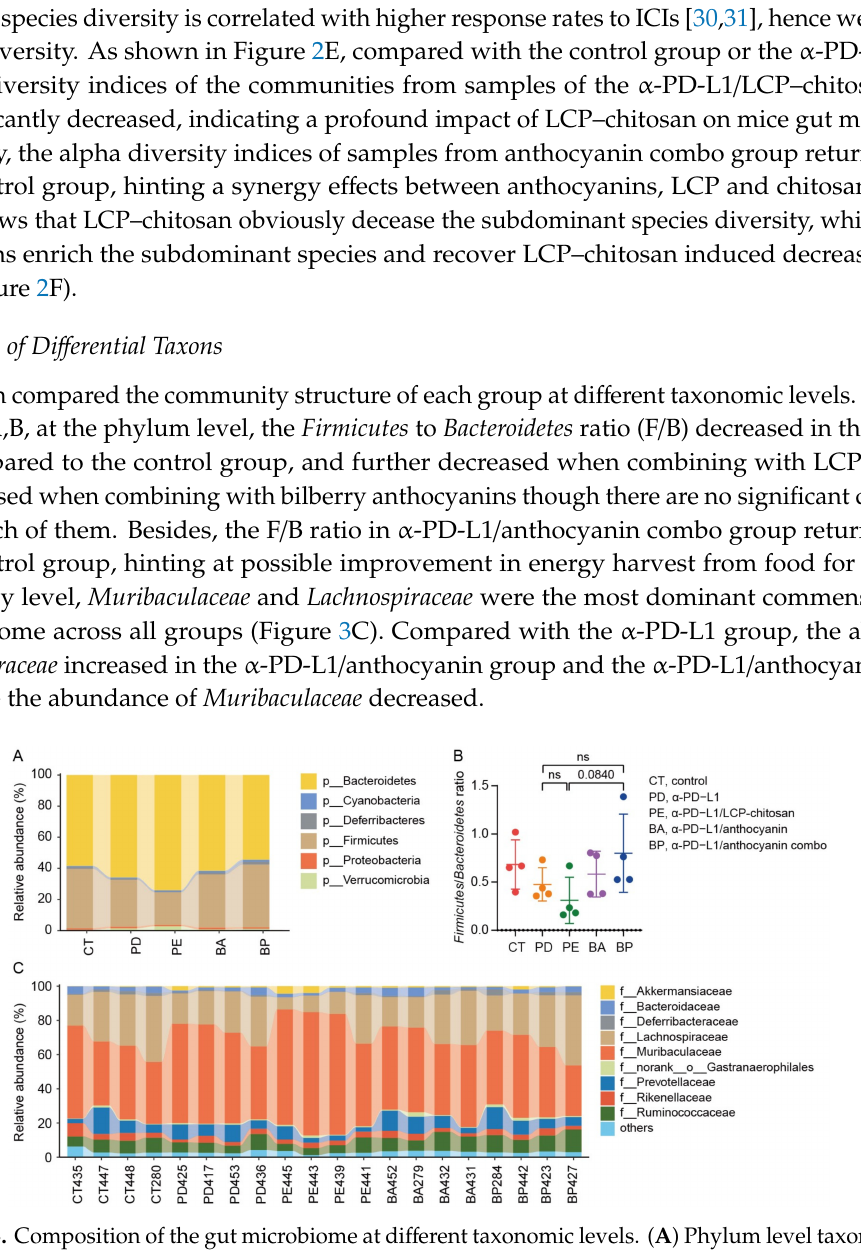
Figure 3. Composition of the gut microbiome at di ff erent taxonomic levels. ( A ) Phylum level taxonomic composition of bacterial communities in each group. ( B ) The Firmicutes to Bacteroidetes ratio. ( C ) Taxonomic composition of the bacterial communities in each group at family